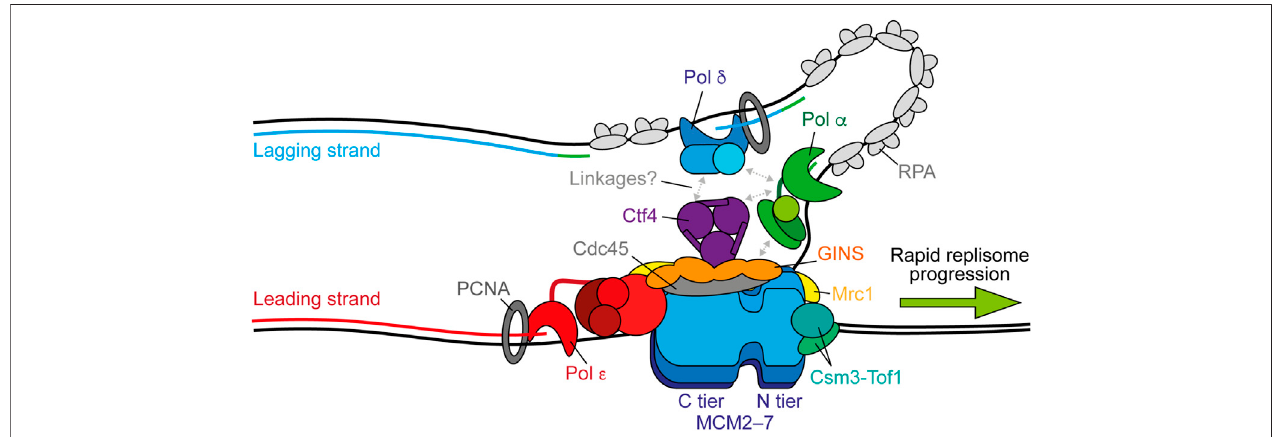
FIGURE1| Replisomearchitectureduringunperturbed progression.CMG(Cdc45-GINS-MCM2-7)tracksalongtheleadingstrand tounwind theparentalduplex. Pol ε synthesises the leading strand continuously in complex with CMG. Pol α initiates discontinuous lagging-strand synthesis through regular priming. Primers are extended byPol δ to form Okazaki fragments thatare ligated together toproduce acontinuous daughter strand. Possible physical links between Pol α ,Pol δ , Ctf4 (And- 1), and CMG are indicated by gray arrows. Both Pol ε and Pol δ associate with PCNA during synthesis and RPA binds any exposed ssDNA. Csm3-Tof1(Tipin- Timeless) bind ahead of CMG and contact the parental duplex. Mrc1 (Claspin) may bind across one side of CMG spanning the N and C tiers. Synthesis by Pol ε , Pol δ , and Pol α is shown in red, blue, and green